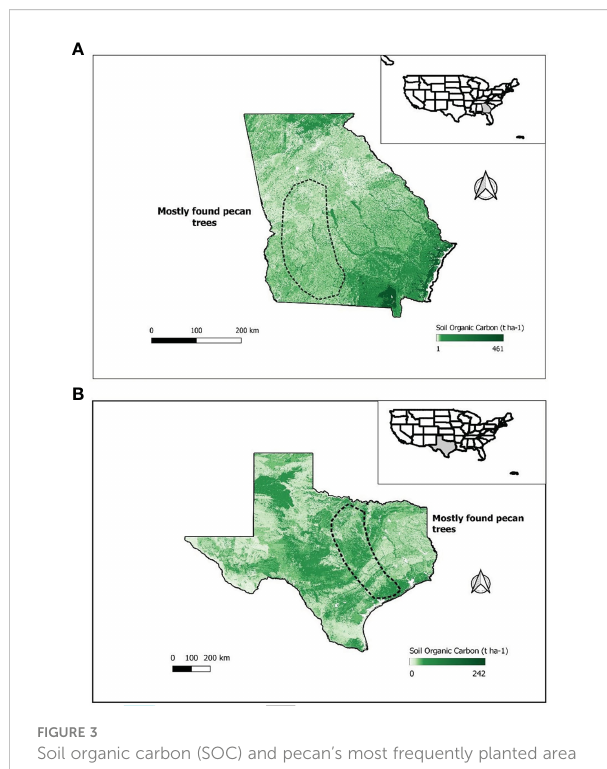
FIGURE 3 Soil organic carbon (SOC) and pecan ’ s most frequently planted area according to Hall (83) for (A) Georgia and (B) Texas states. Source: own elaboration in QGis v. 3.26.2 (2022) based on the Global Soil Carbon Map (84). The map in the upper right indicates the location of the states in the USA.